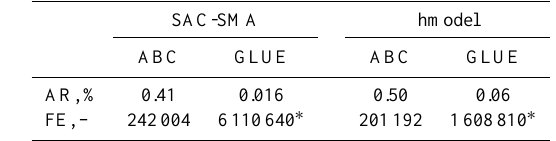
Fig. 5. Posterior distribution of five randomly chosen SAC-SMA model parameters derived from (A) GLUE and (B) ABC using his- torical streamflow data from the French Broad river basin.